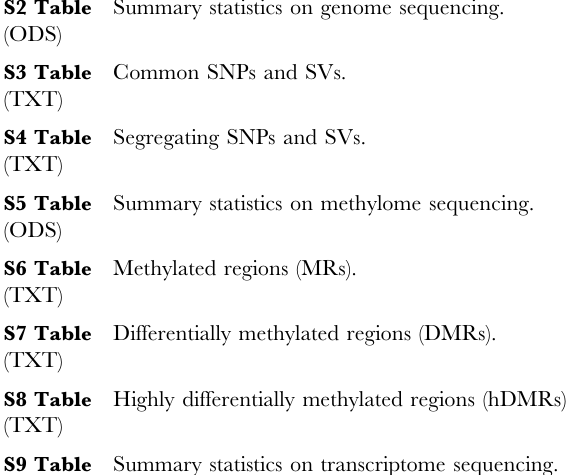
S9 Table Summary statistics on transcriptome